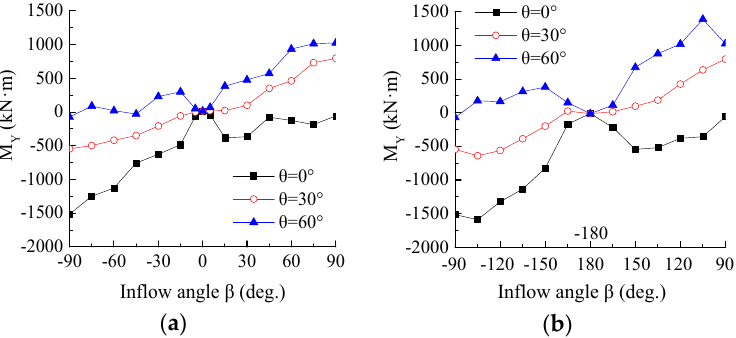
Figure 13. Curves of variation of the averages pitching moment M Y with wind direction: ( a ) The average pitching moment M Y in the wind direction interval ( − 90 , 90 ); ( b ) The average pitching moment M Y in the wind direction intervals ( − 180 , − 90 ) and (90 , 180 ).